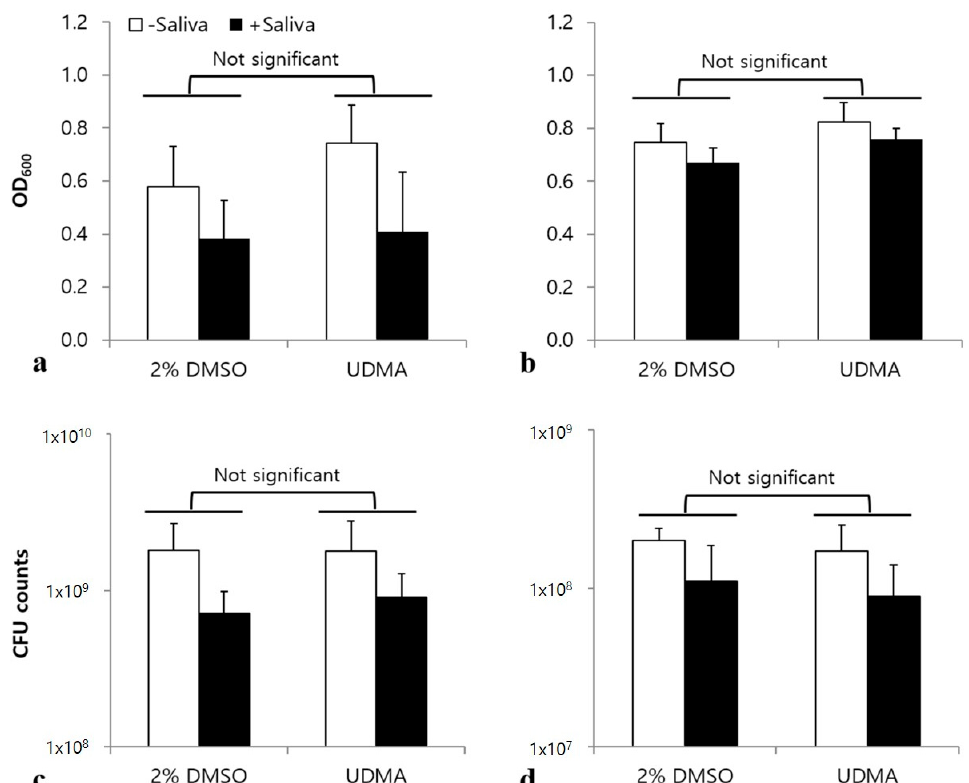
Figure 11. Effects of UDMA on biofilm formation by S. mutans UA159 on a surface coated with saliva, and one not coated with saliva in a glucose-containing medium ( a ), and sucrose-containing medium ( b ), as determined by crystal violet staining. Number of viable cells in the glucose-containing medium ( c ), and sucrose-containing medium ( d ). Biofilms were formed in the presence and absence of a saliva coating on the surface. DMSO was used as a vehicle for UDMA, and cells not treated with UDMA served as the control (2% DMSO). Data are representative of three independent experiments, and are expressed as mean ± standard deviation values (Two-way analysis of